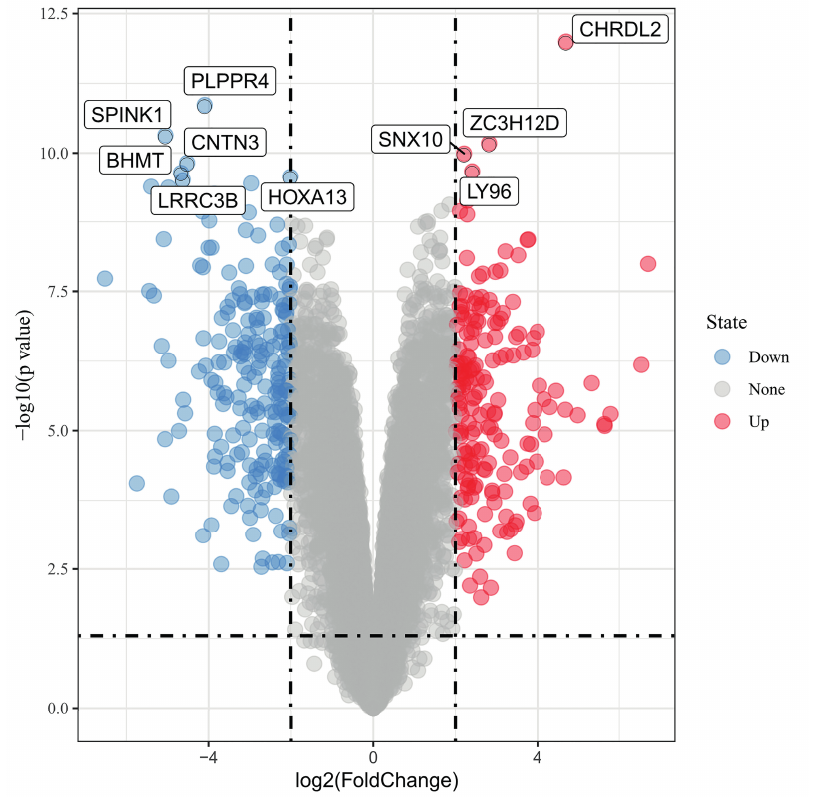
Figure 1 - The volcano plots of differentially expressed genes (DEGs). Red represents up-regulated DEGs and blue represents down-regulated